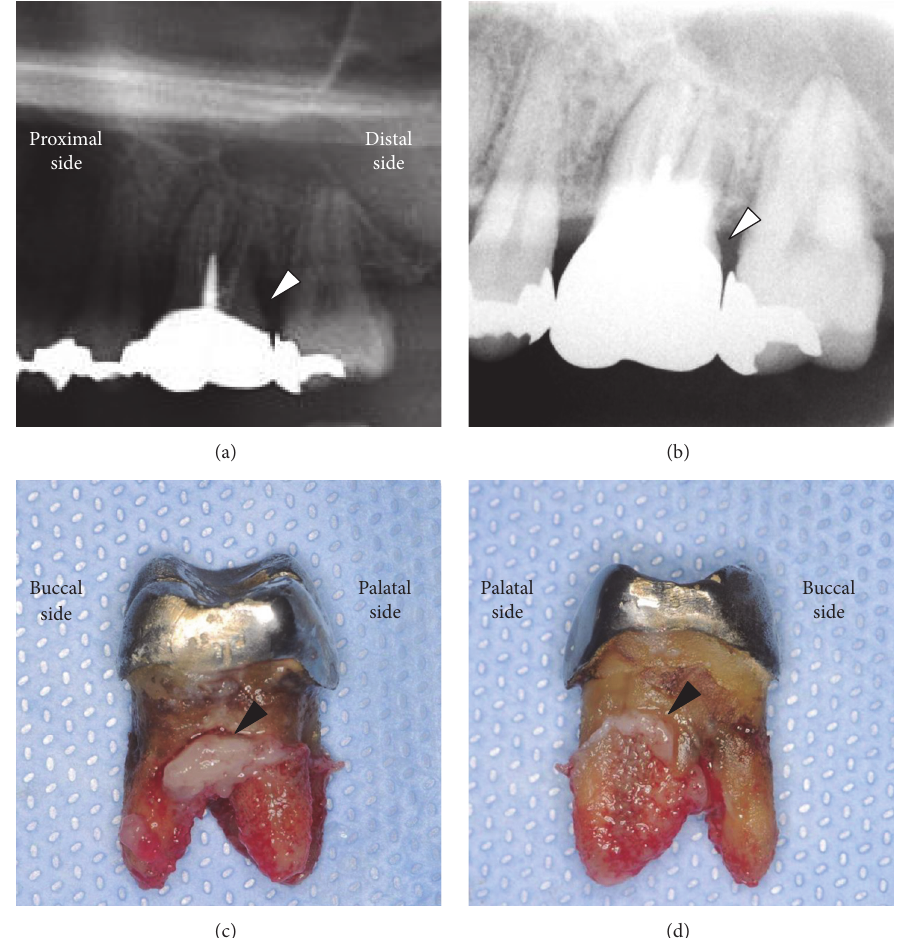
Figure 3: (a, b) Panoramic and dental radiographic images after embolization. The maxillary left first molar with crown and root filling material had a carious cavity on the distal side (white arrowhead). There was no defect in the alveolar bone. (c) The proximal and (d) distal sides of the extracted tooth. Cavities, remarkable calculus accumulation on the root surface, and infectious granuloma (arrowhead) were